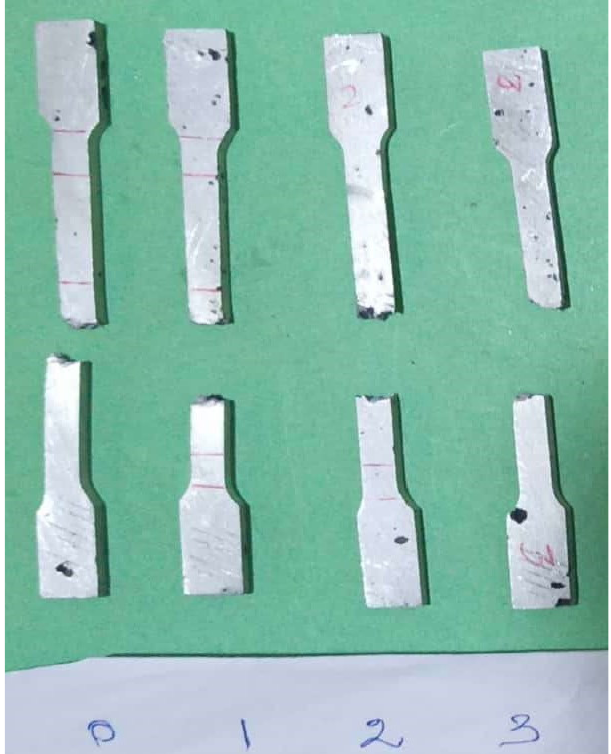
Figure 13. Fractured tensile test specimens.